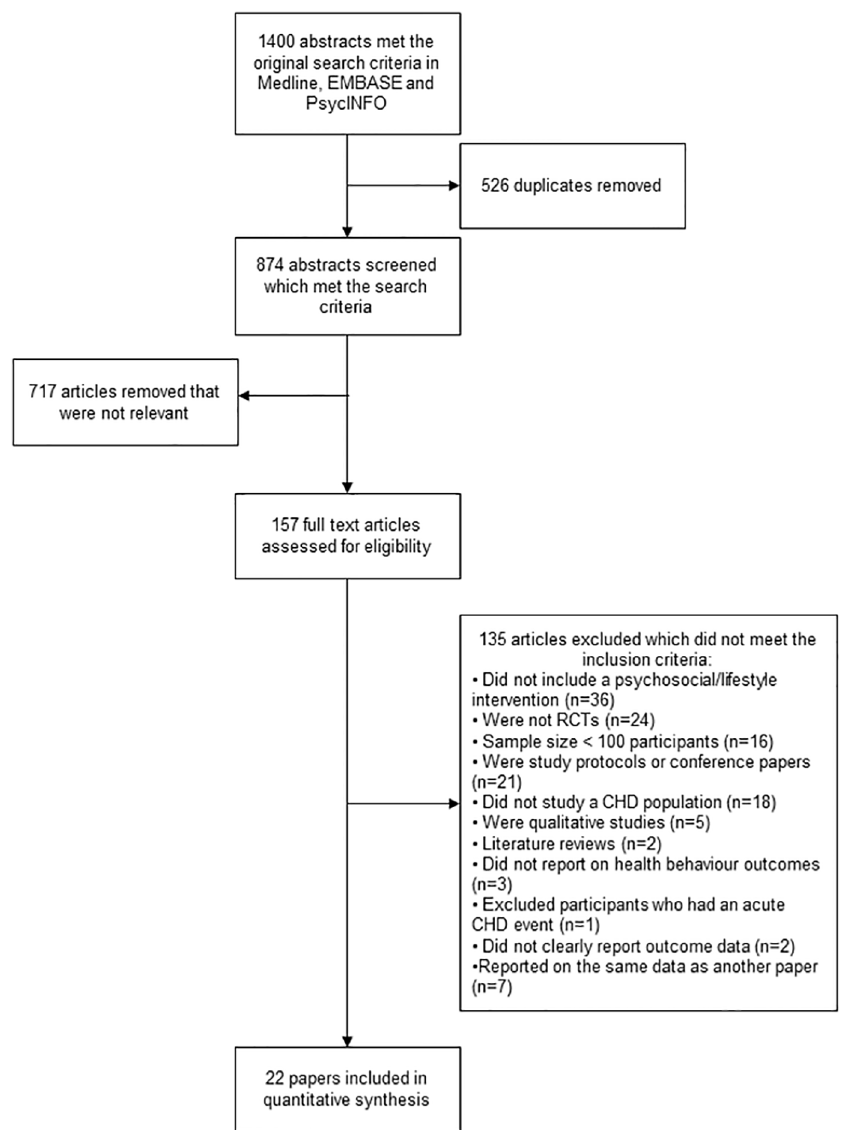
Fig 1. PRISMA flow diagram showing the search process and selection of relevant